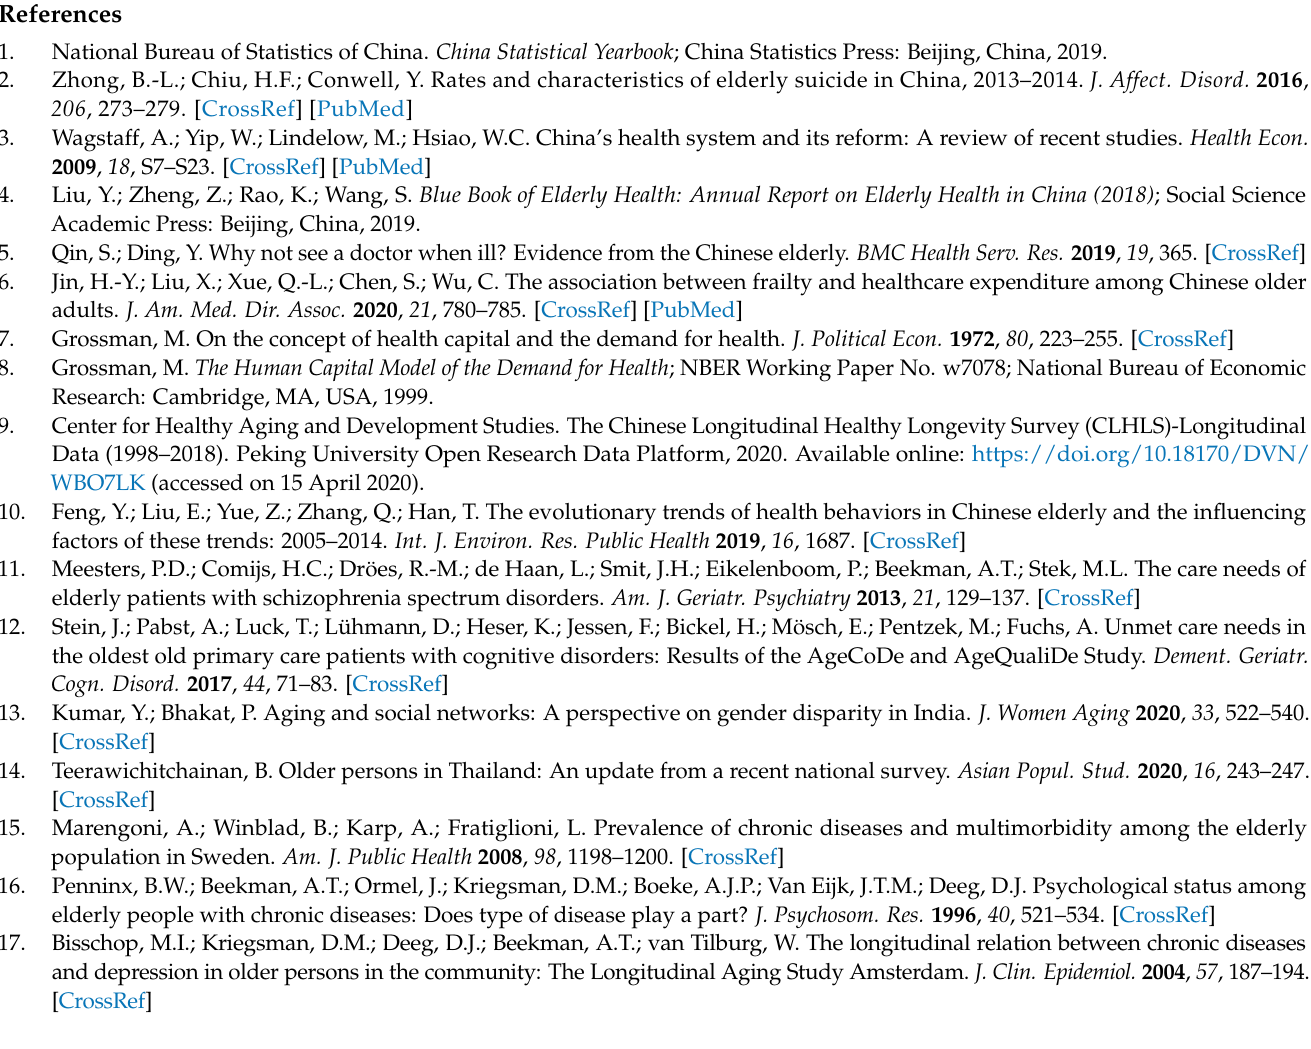
Table S4: Multiple linear regression on elderly HCD, Table S5: Multiple linear regression on elderly